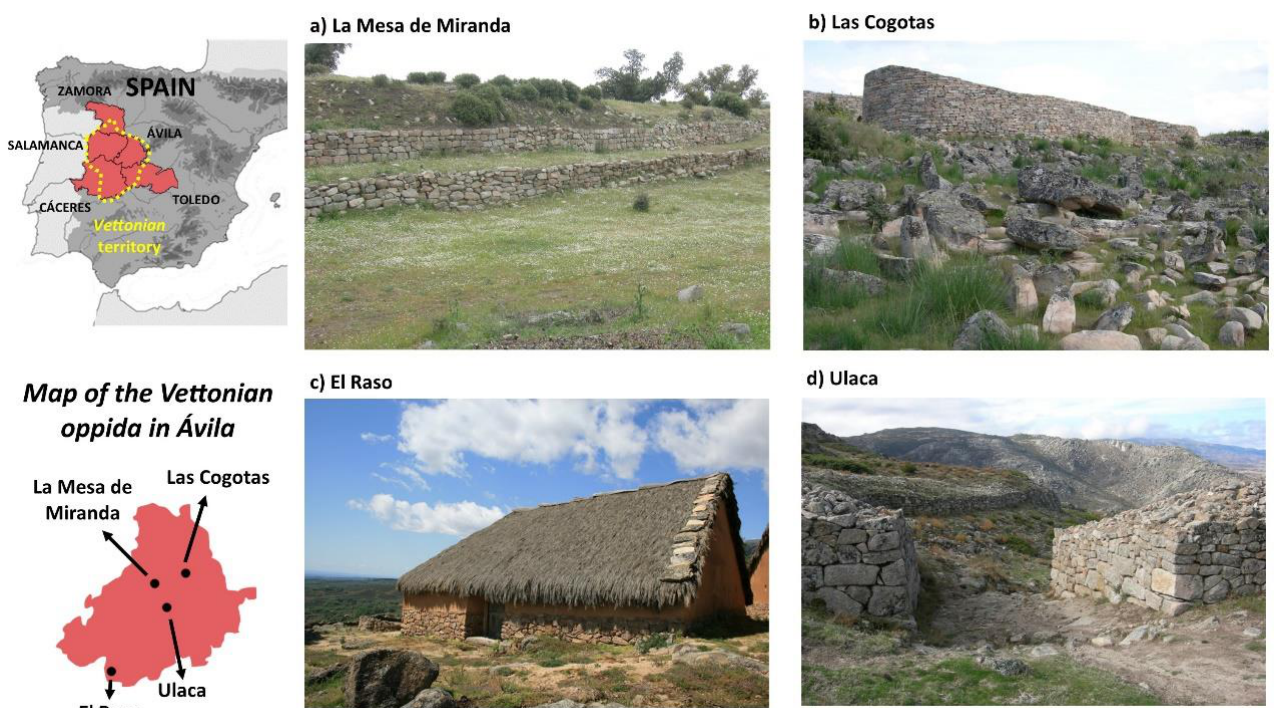
Figure 1. Main Vettonian oppida in Á vila: ( a ) La Mesa de Miranda, ( b ) Las Cogotas, ( c ) El Raso and ( d ) Ulaca.